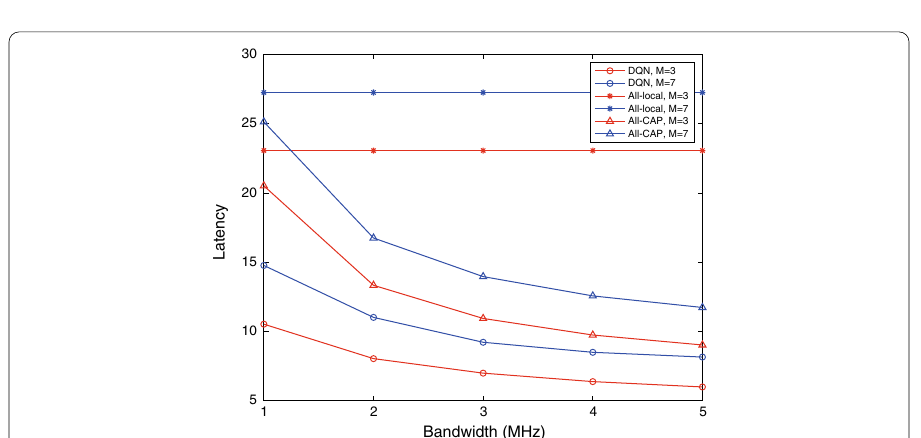
Fig. 5 Effect of the bandwidth on the system latency of the three